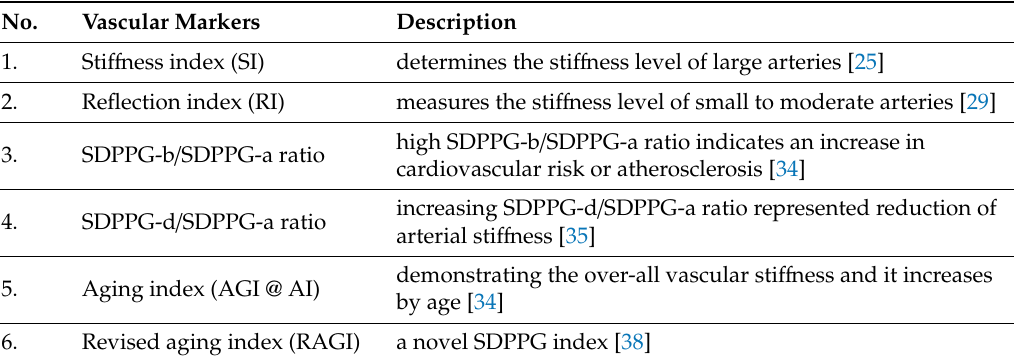
Table 1. Brief description of vascular